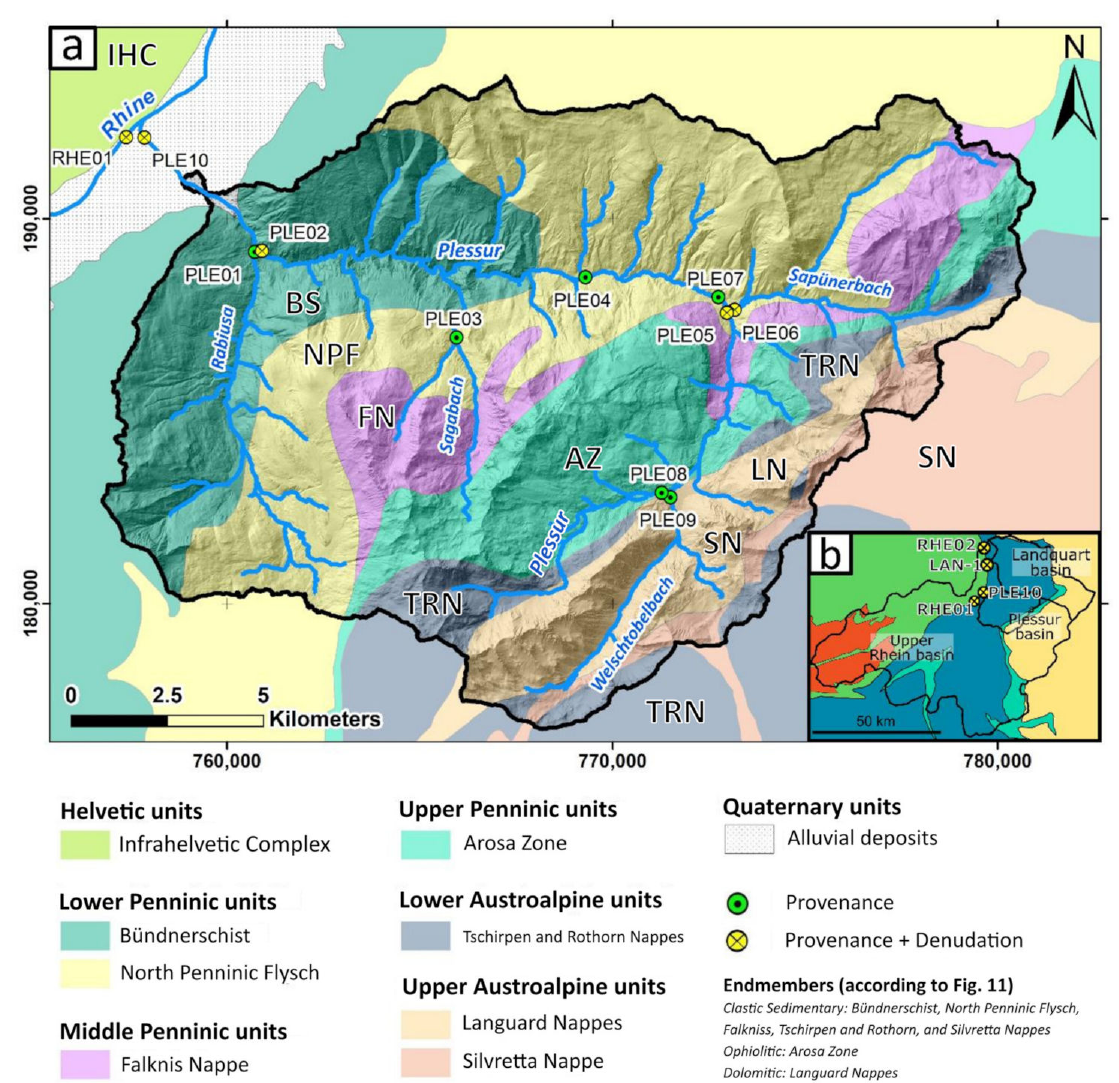
Figure 2. ( a ) Lithotectonic framework of the Plessur drainage basin and its main tributaries, and locations of collected samples. IHC: Infrahelvetic Complex; BS: Bündnerschist; NPF: North Penninic Flysch; FN: Falknis Nappe; AZ: Arosa zone; TRN: Tschirpen and Rothorn Nappes; LN: Languard Nappe; SN: Silvretta Nappe; Q: Quaternary deposits; ( b ) Location of samples used in this study but collected outside of the Plessur Basin. Samples RHE01 and RHE02 were collected in the Rhine River and are part of this work’s dataset, whereas sample Lan-1 was collected at the outlet of the Landquart River and is part of the work by [22]. Green dots indicate sites where samples have been processed for provenance tracing purposes only, whereas yellow dots represent sites where the samples have been analyzed for both provenance and concentrations of 10 Be. Refer to Figure 1 for the explanation of colors. The numbers at the border of the figure indicate the Swiss coordinates in